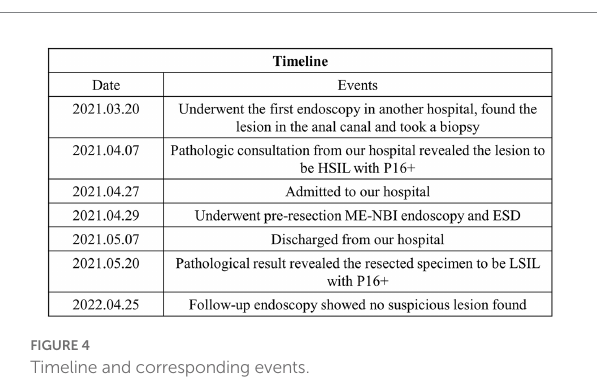
FIGURE 4 Timeline and corresponding